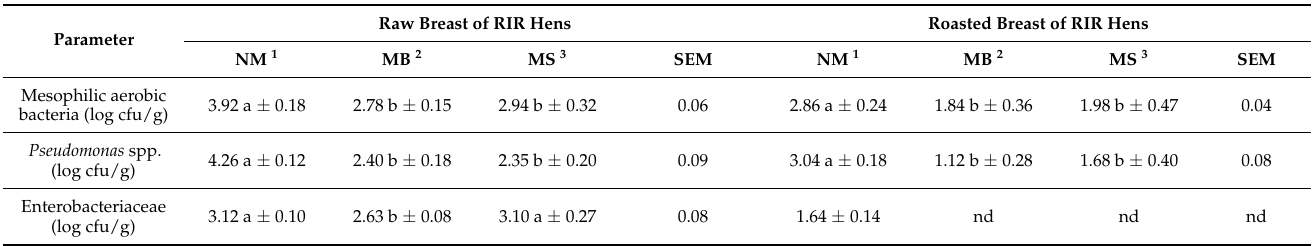
Table 3. Effect of marinating with fermented milk products on the microbiological parameters of raw and roasted hen breast